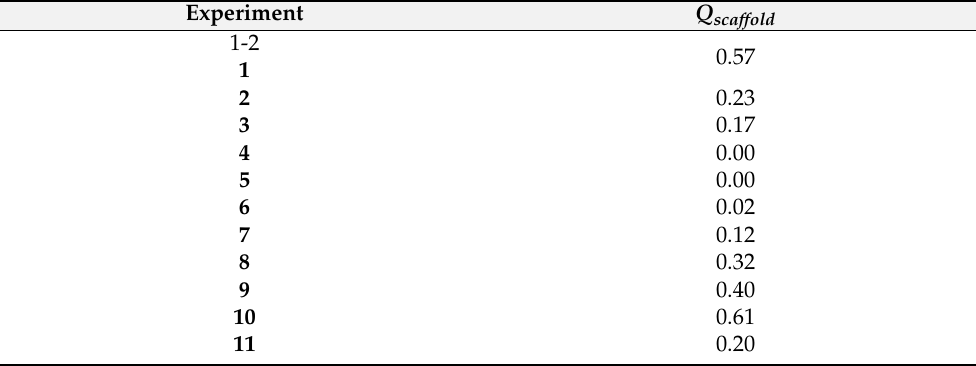
Table 2. Design of experiments: Qscaffold values for each